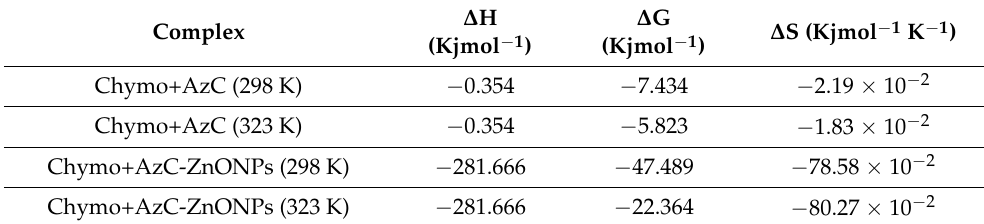
Table 3. Thermodynamic Parameters for the interaction of Chymo-AzC and AzC-ZnONPs at two different temperatures (298 K & 323